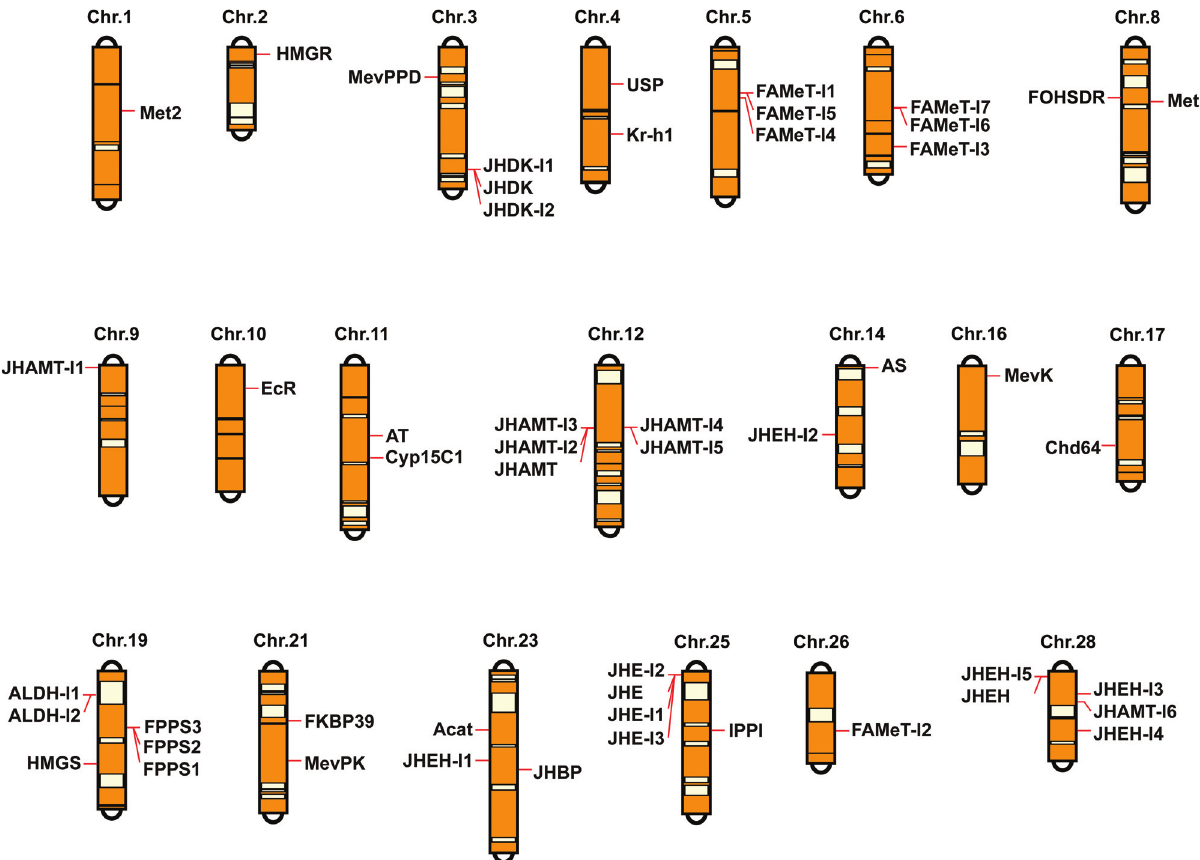
Figure 1 - Chromosomal distribution of JH-related genes in B. mori. Based on the assembly of the whole-genome sequence and single-nucleotide poly- morphism (SNP) markers linkage map for B. mori , a total of 52 JH-related genes were mapped on the different chromosomes of B. mori . Several different copies of each of the JH-related genes with multiple copies are clustered in tandem on the